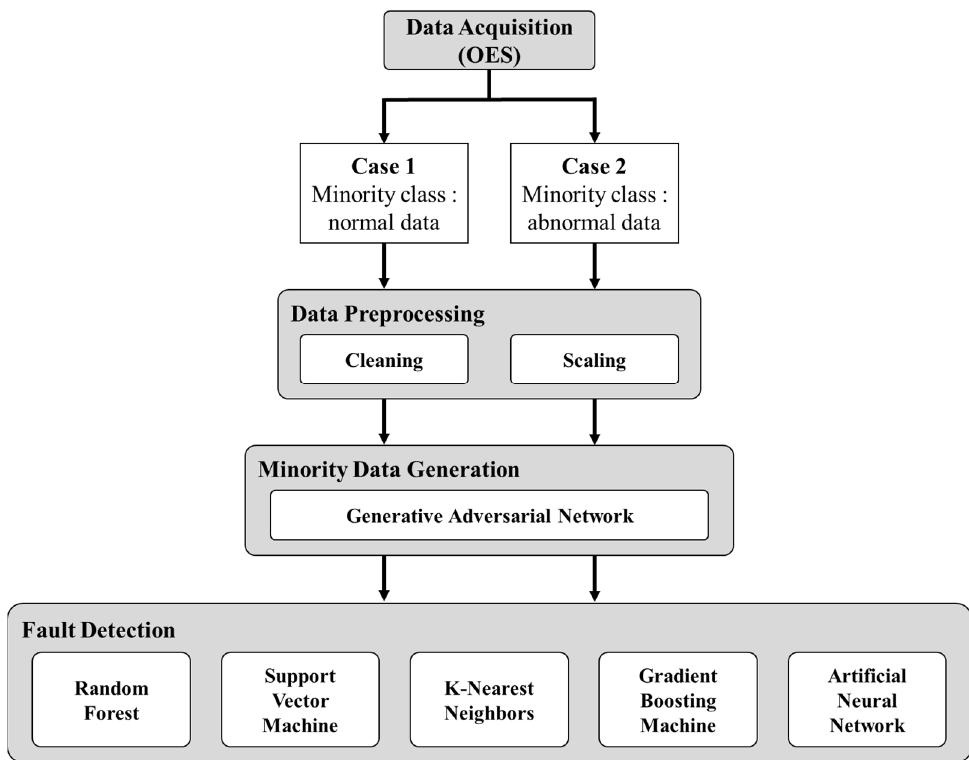
Figure 1. Flowchart of the fault detection using the GAN.